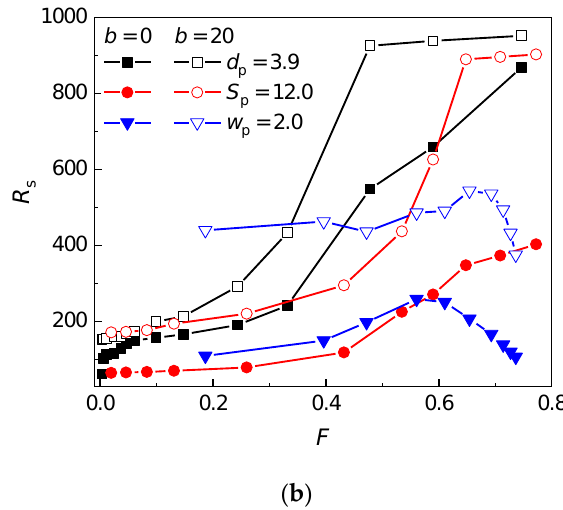
Figure 3. Axial chain extension of a flexible ( b = 0) and semiflexible ( b = 20) chain in a post array with the geometry variation at constant post diameter d p , post separation S p , and passage width w p as a function of the d c / w p ratio ( a ) and the volume fraction of posts F ( b ).